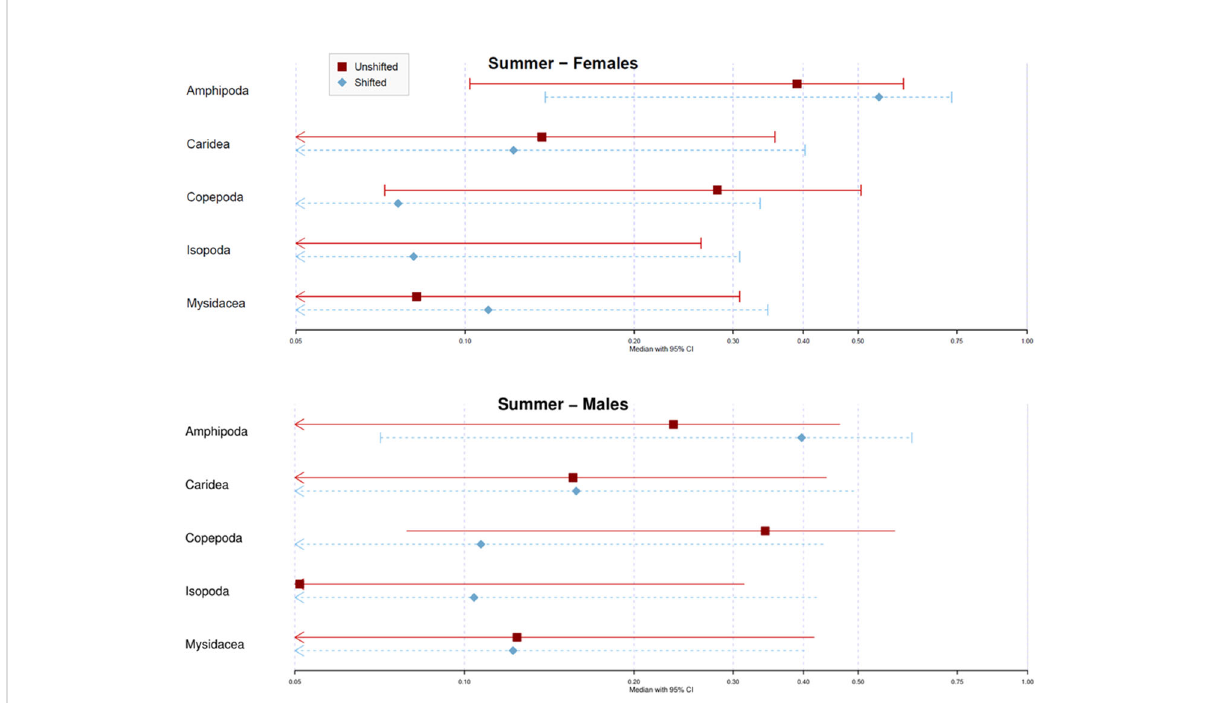
FIGURE 6 Seasonal assessment - Posterior proportional contribution for Syngnathus acus as estimated by Bayesian Stable Isotope Mixing Model (SIMM). Analyses based on isotopic ( d 13 C and d 15 N) data for dorsal fi n tissues of specimens sampled on C ı ́ es Archipelago in summer 2017 and summer 2018 (Pooled samples). Treatments: average isotopic values of potential prey sampled concomitantly with consumers (Unshifted) or in the previous season of consumer sampling (Shifted). Symbols represent the median contribution of each key source with 95% (lines) credible